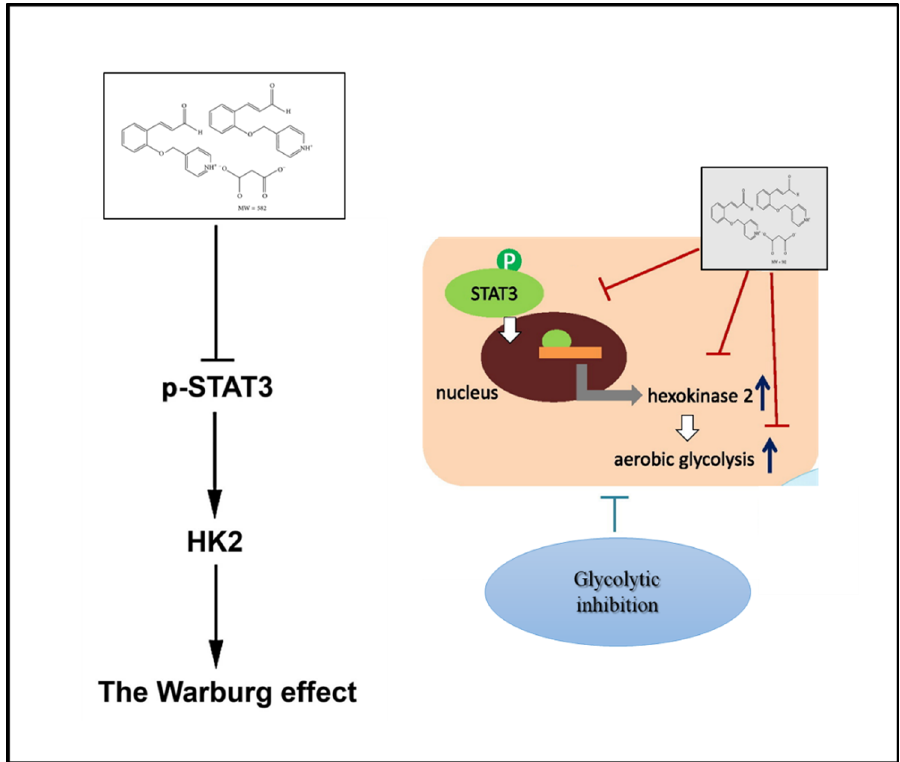
Figure 6. Schematic diagram of the apoptotic effect of CB-PIC through anti-Warburg effect via inhibition of p-STAT3 and pyruvate signaling.